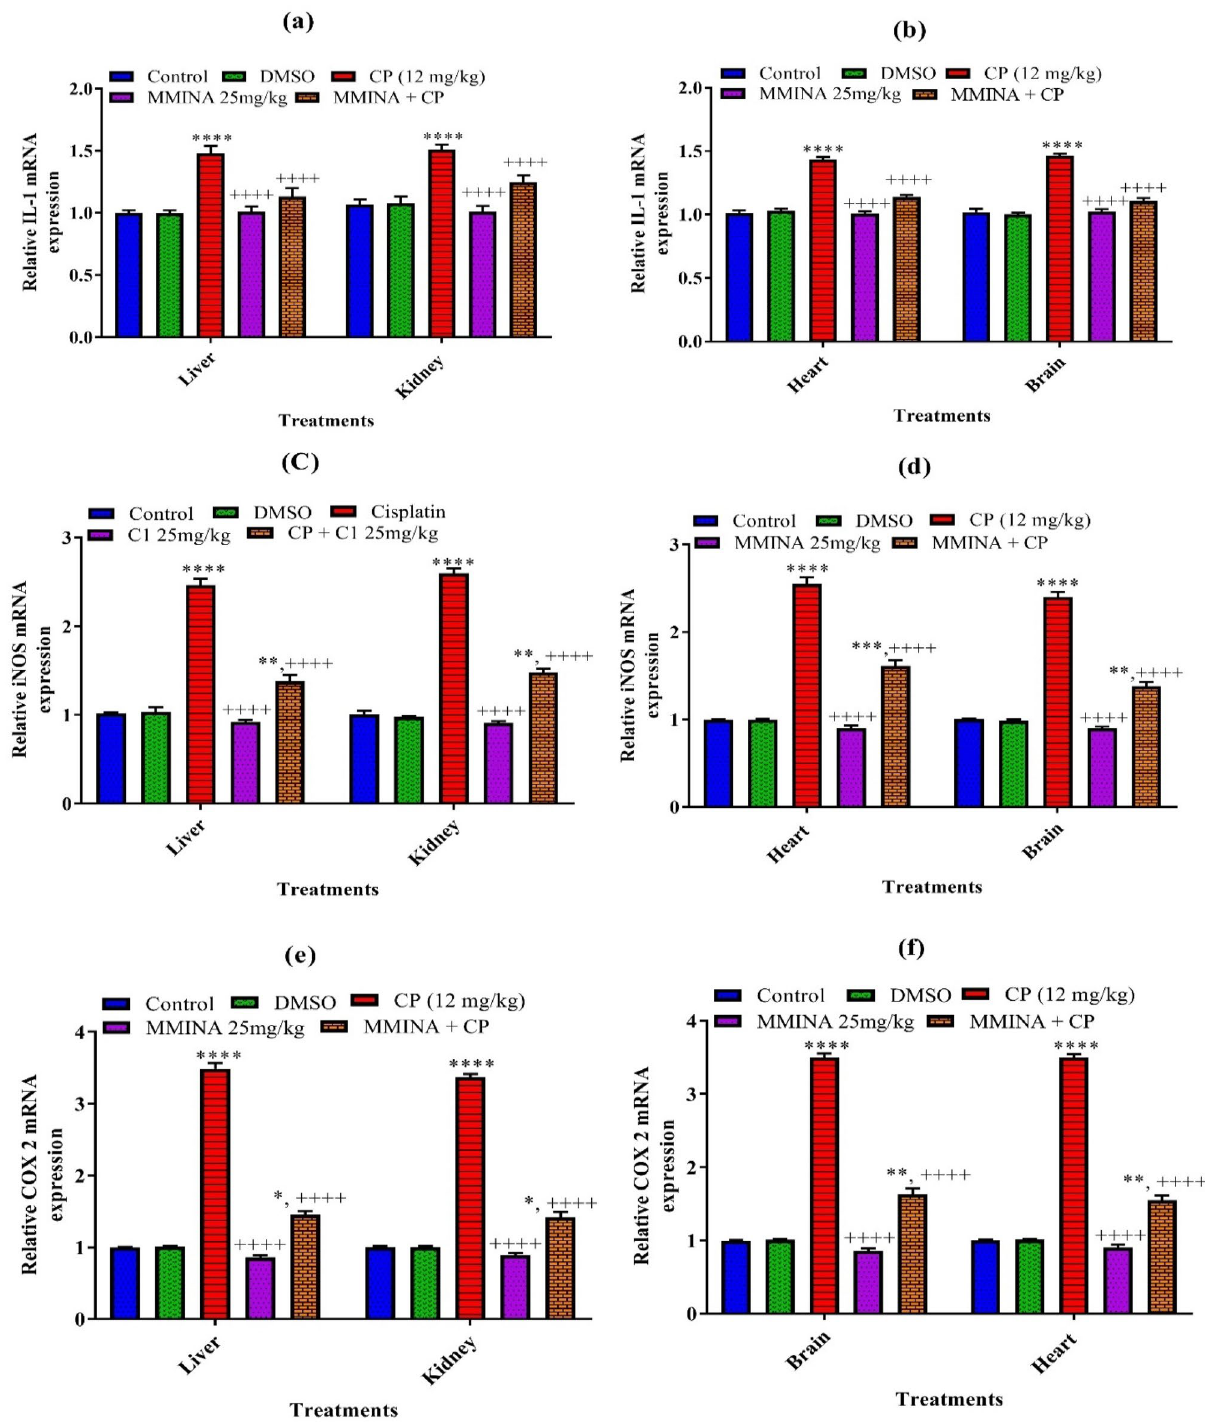
Figure 3. Effect of MMINA treatment on the gene expression of STAT-3, NF-κBp65, TNF-α. mRNA expression was measured by quantitative RT-PCR in the in Liver Kidney, heart and brain tissues. Data are mean ± SEM, (n = 6). *, **** p < 0.05 and p < 0.0001 versus Control respectively, and ++++ p < 0.0001 versus CP. Data analyzed by One-way ANOVA followed by Tukey’s multiple comparison